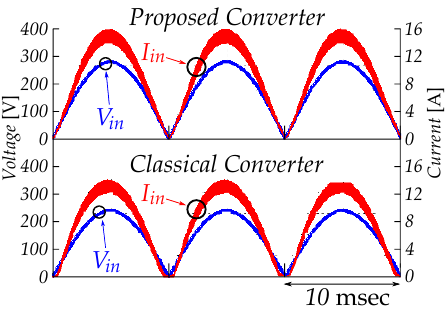
Figure 7. Comparison under the condition of nominal power and nominal output voltage.